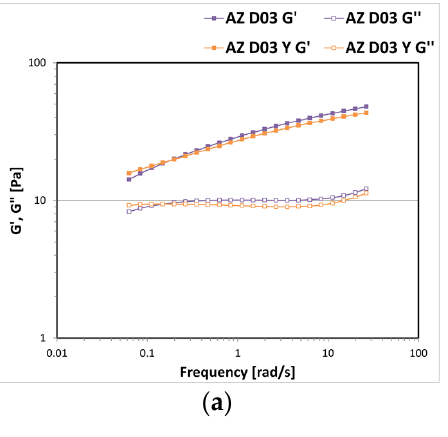
Figure 13. Storage G’ and loss G’’ moduli trend as a function of the oscillation frequency ( a ) and texture curves obtained from an immersion/de-immersion test ( b ) for the emulsions prepared with A-Z associations (ratio 1:1) at a total solid amount of 10% w/w, D at 0.3% w/w, an oily phase at 10% w/w with and without 3% w/w of a pigments mixture Y.